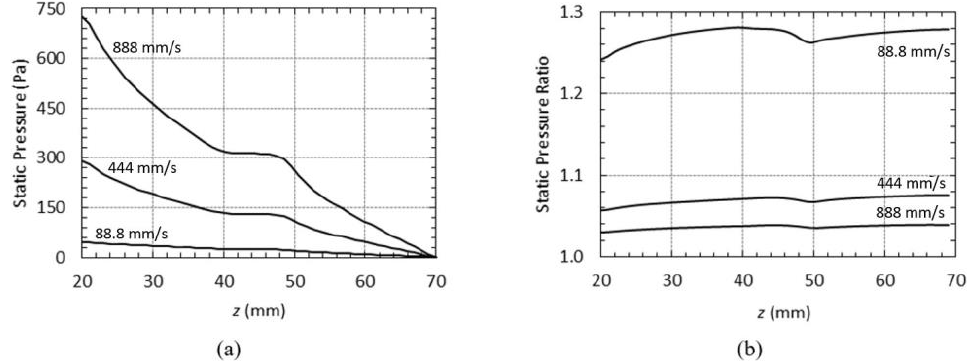
Figure 9. ( a ) Static pressure along the channel for Carreau model and different velocities. ( b ) Ratio between static pressure for Carreau and Newtonian models.